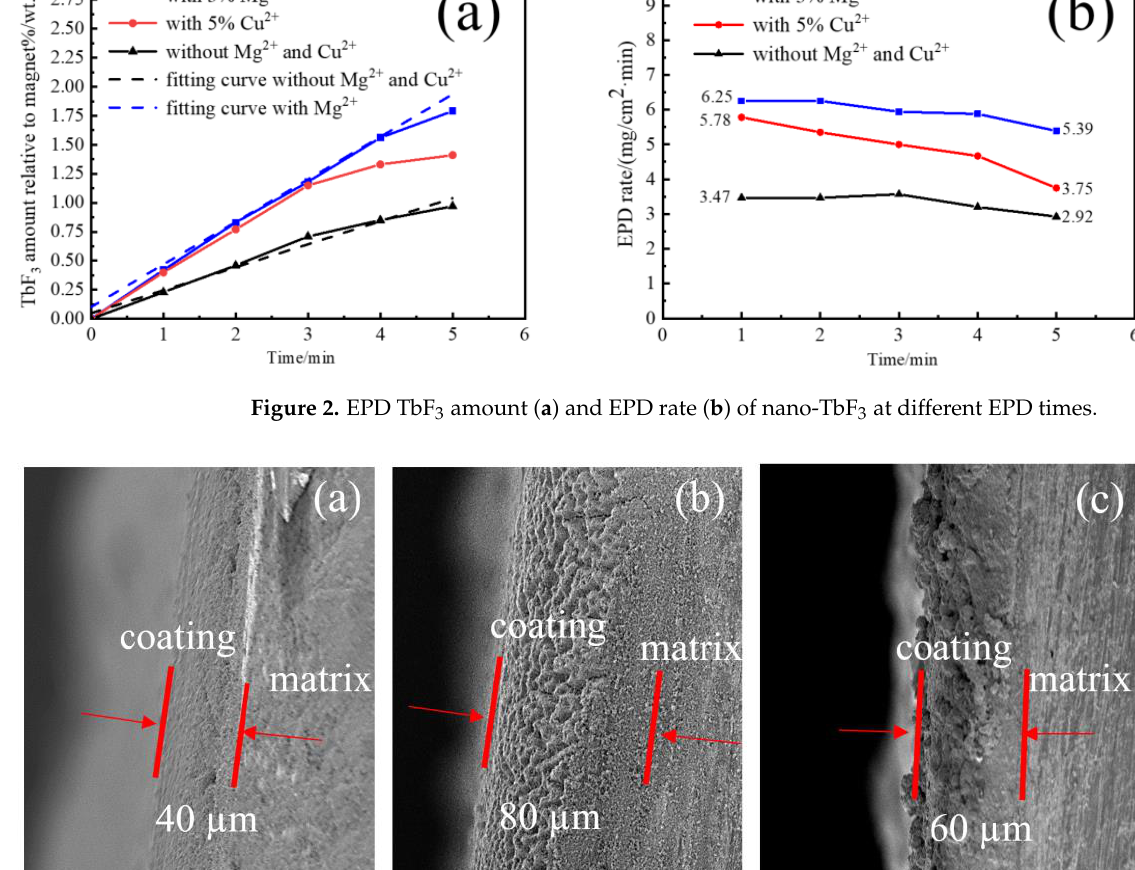
Figure 2. EPD TbF 3 amount ( a ) and EPD rate ( b ) of nano-TbF 3 at different EPD times.